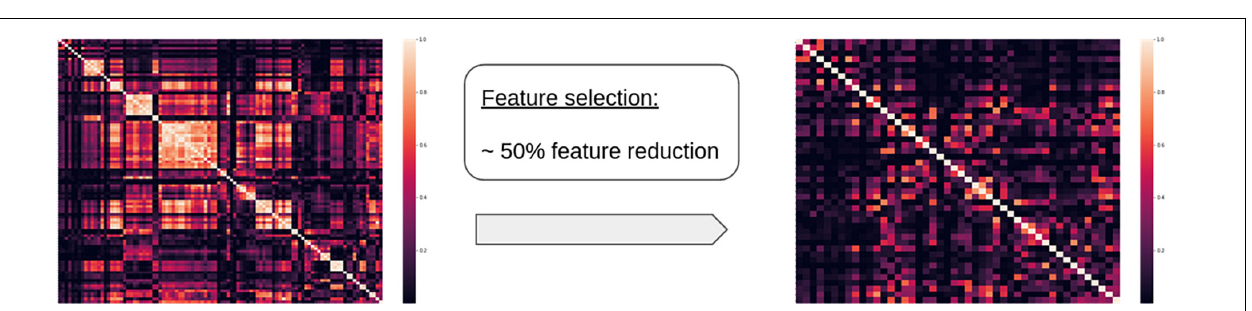
FIGURE 1 | Schematic pipeline for extracting radiomics features from sMRI.